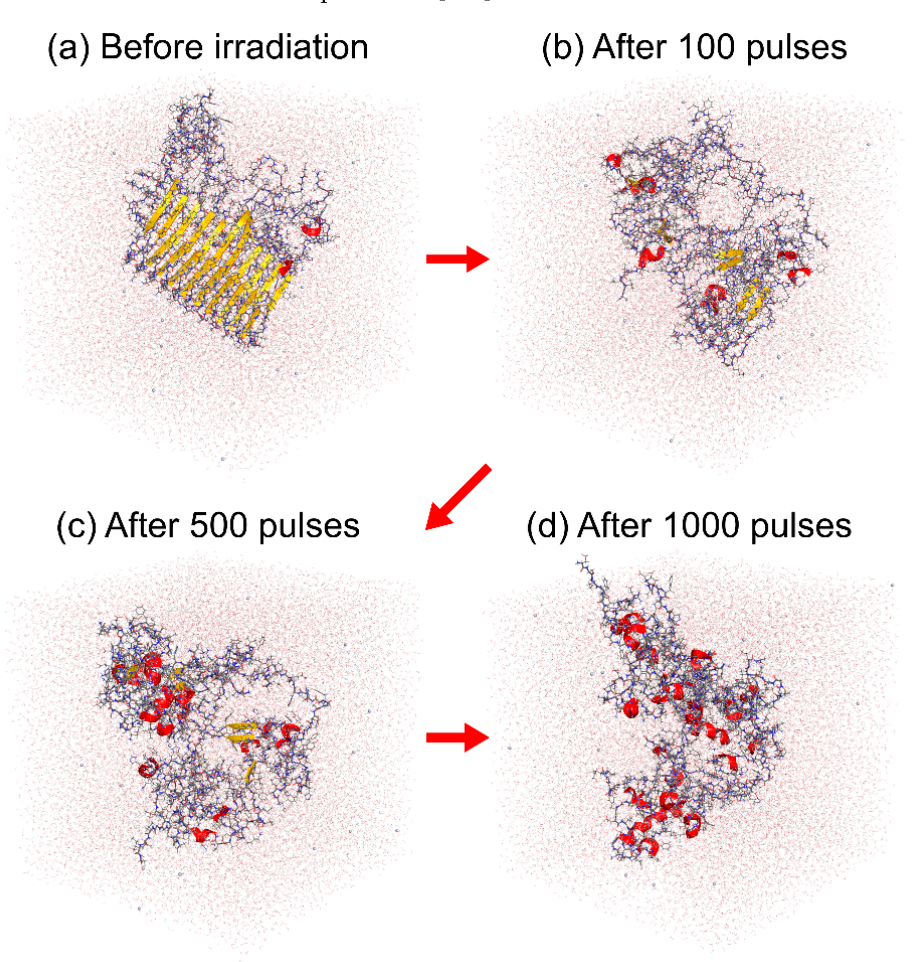
Figure 15. Snapshots during the laser-induced disruption process of the A β amyloid fibril in the nonequilibrium MD simulation ( a ) before IR-FEL irradiation, ( b ) after 100 pulses, ( c ) after 500 pulses, and ( d ) after 1000 pulses. The images were created using PyMOL [171].